Question: Identify the chart type used in this figure.
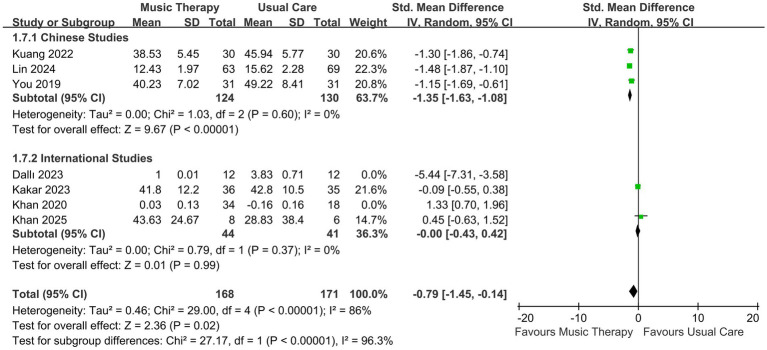
Answer: forest